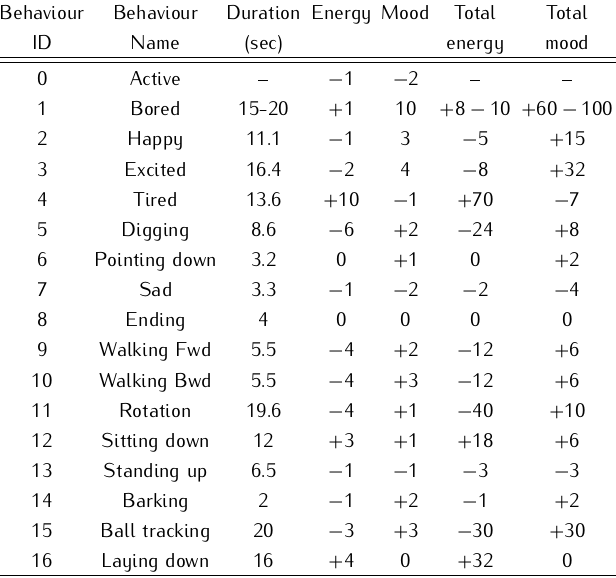
Table 2. List of robot behaviours and how they affect the robot’s internal states (in a 2-second interval: every 2 seconds energy and mood levels are increased or decreased based on the static values as shown in the